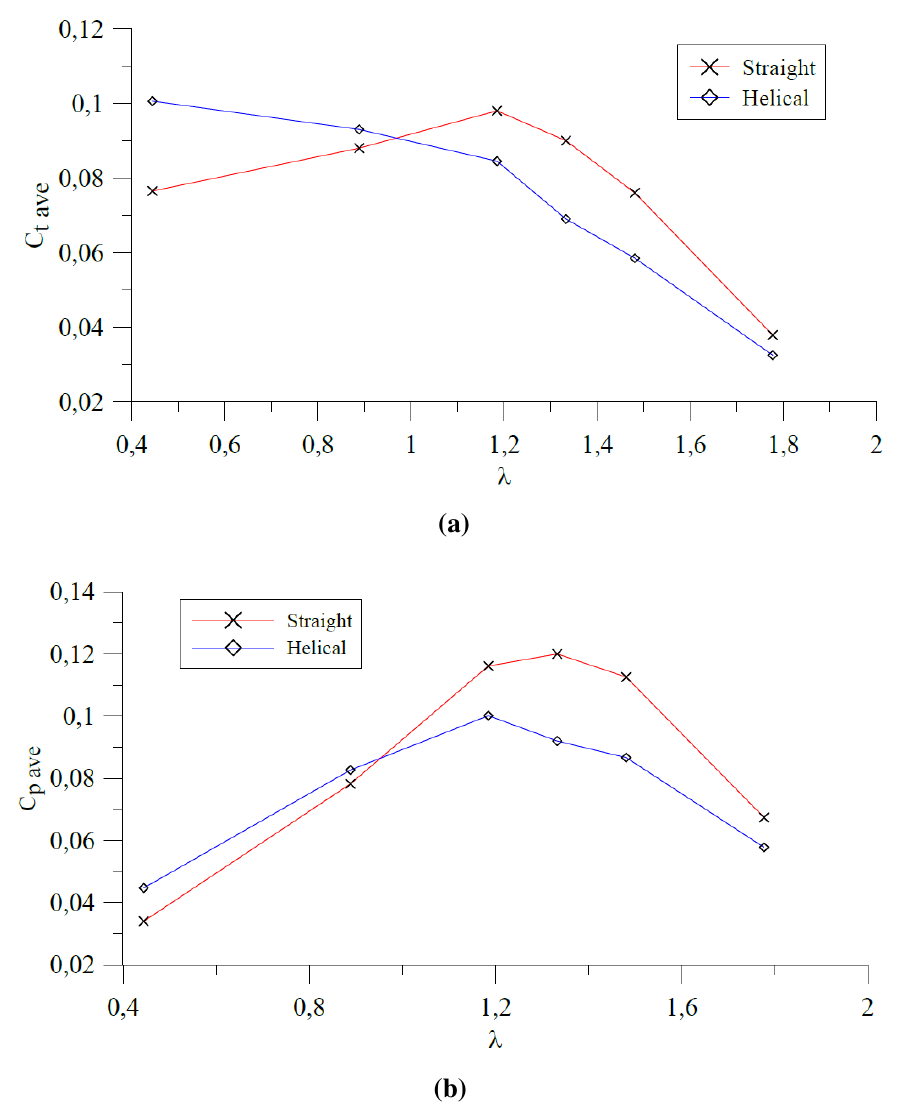
Figure 15. Comparison of the average torque and power coefficient for the Straight and Helical ( ψ = 60 ◦ ) three-dimensional turbines. ( a ) Torque coefficient for Straight and Helical configurations; ( b ) power coefficient for Straight and Helical